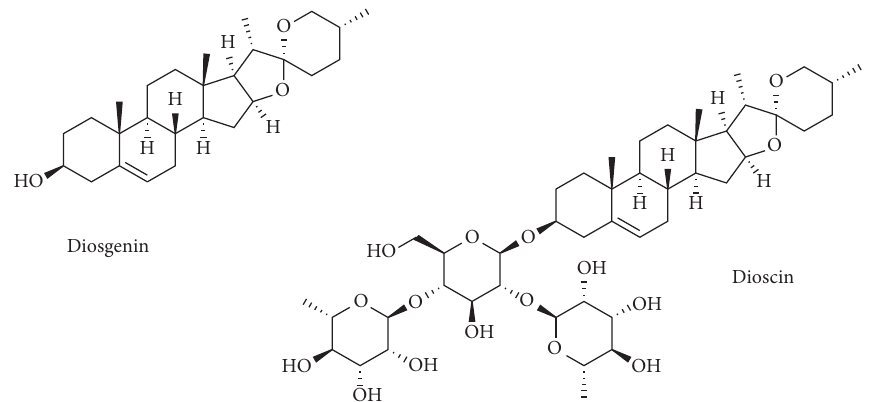
Figure 1: Chemical structures of diosgenin and